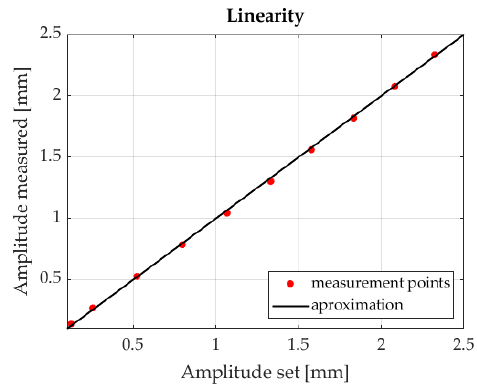
Figure 17. Vibration amplitude measurements.